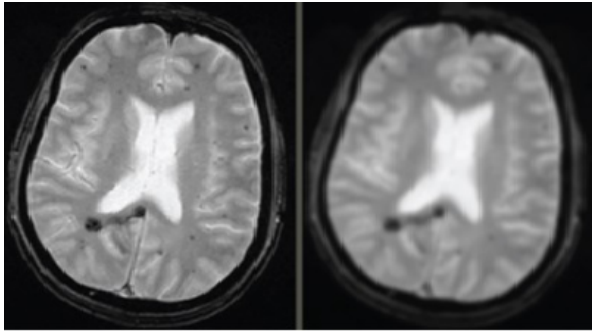
Figure 2: Application of the Smoothing Recursive Gaussian Image Filter. Left: Original image. Right: Blurred image after applying the